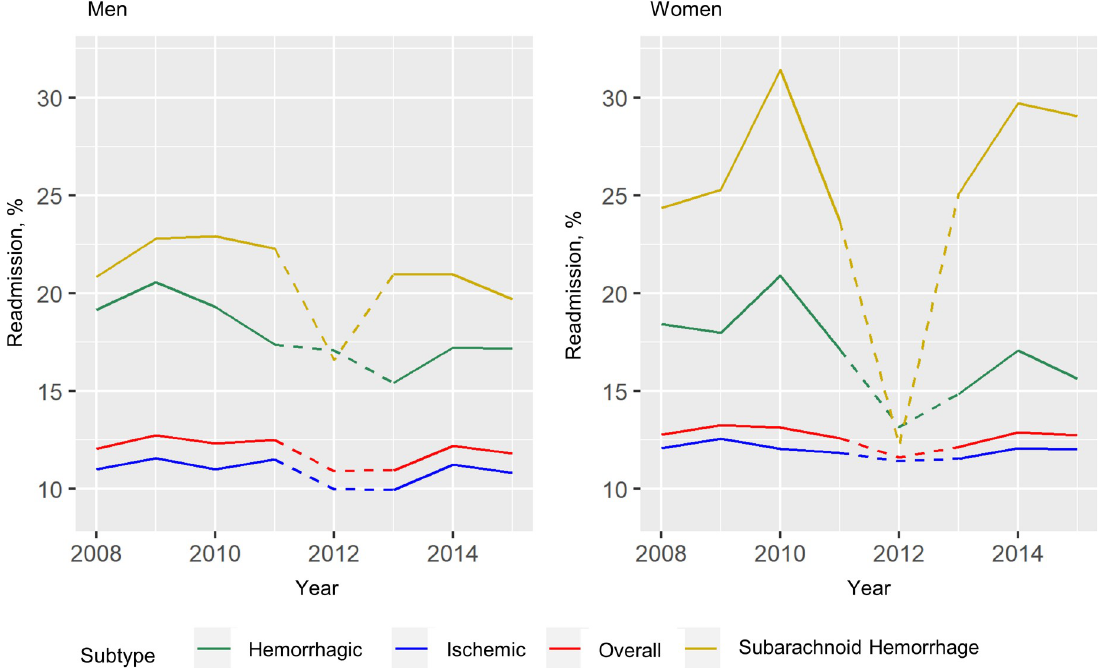
Fig 2. Age-standardized 28-day readmissions by sex and stroke subtypes. Dashed lines between 2012 and 2013 indicate loss of some data due to disruption in the flow of data entry during database migration.